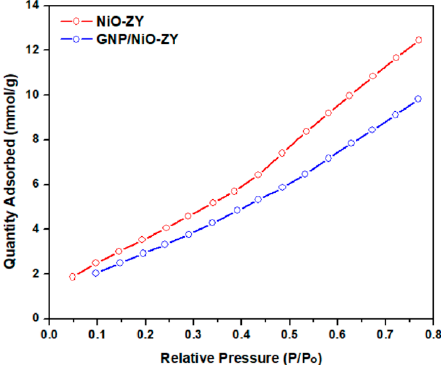
◦ C for NiO-ZY and GNP / NiO-ZY.